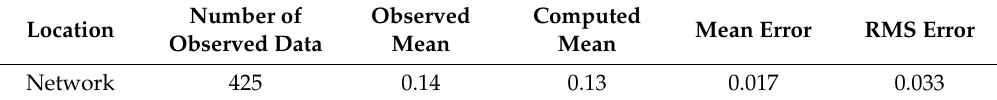
Table 3. Calibration statistics for chlorine concentration (EPANET).